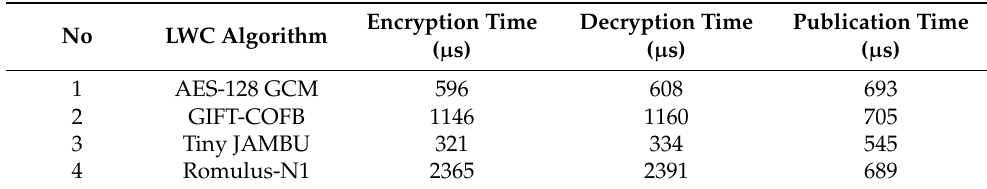
Table 8. Lightweight Cryptographic Encryption and Decryption Performance on NodeMCU with 20 Characters Messages used Registered Account.